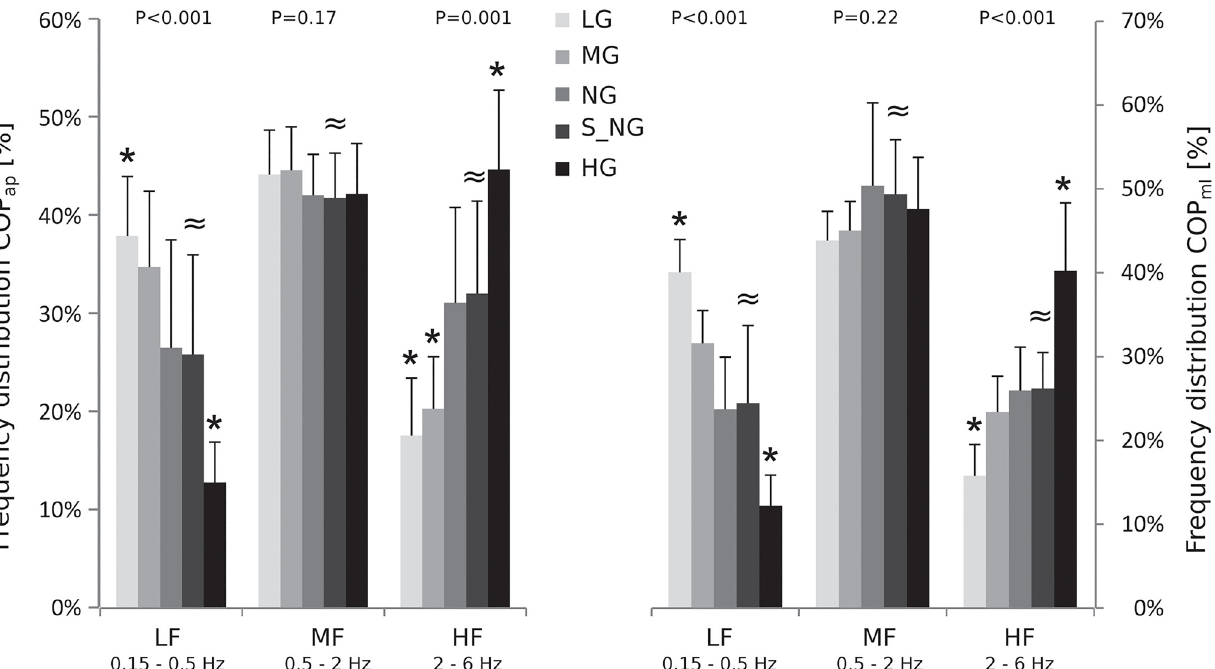
Fig 4. Grand mean of the frequency domains for under and over loading in the four gravity levels (lunar (LG), Martian (MG), normal gravity (NG) and hypergravity (HG)) as well as for the simulated normal loading condition (S_NG): Low frequencies (LF) represent the amount of spectral energy of the frequency spectrum accumulated between 0.15 and 0.5Hz, medium frequencies (MF) the amount accumulated between 0.5 and 2Hz and high frequencies (HF) between 2 and 6Hz. Gravity has a statistically significant influence on HF and LF (P < 0.05, * symbol denotes a statistically significant difference compared to the NG condition). Statistical equivalence (cid:3) between NG and simulated normal loading (S_NG) conditions values could be observed for LF, MF and